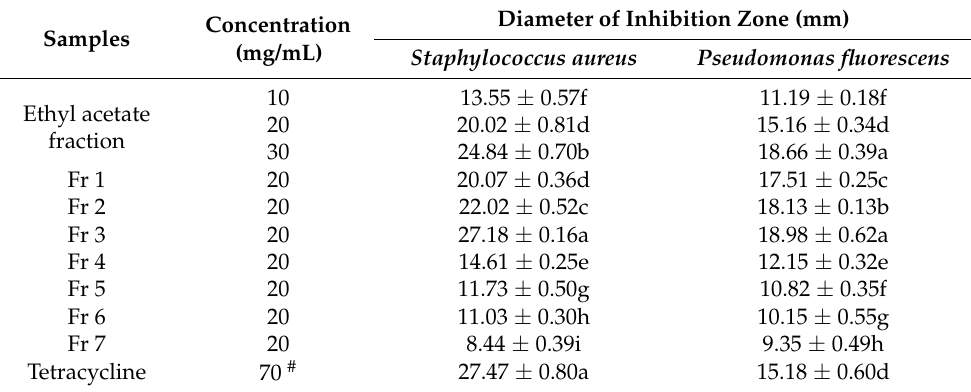
Table 1. Diameters of inhibition zones of ethyl acetate fraction and its sub-fractions from pickled and dried mustard.